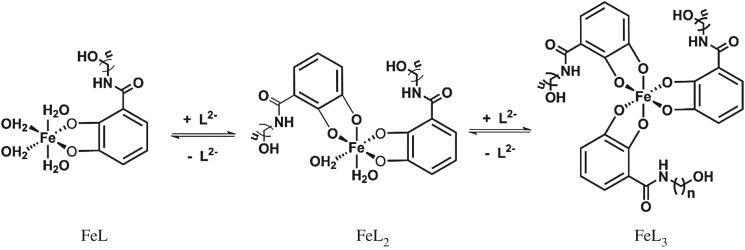
Proposed complexation processes of ligands L1-3H2, the charge numbers are omitted for clarity.